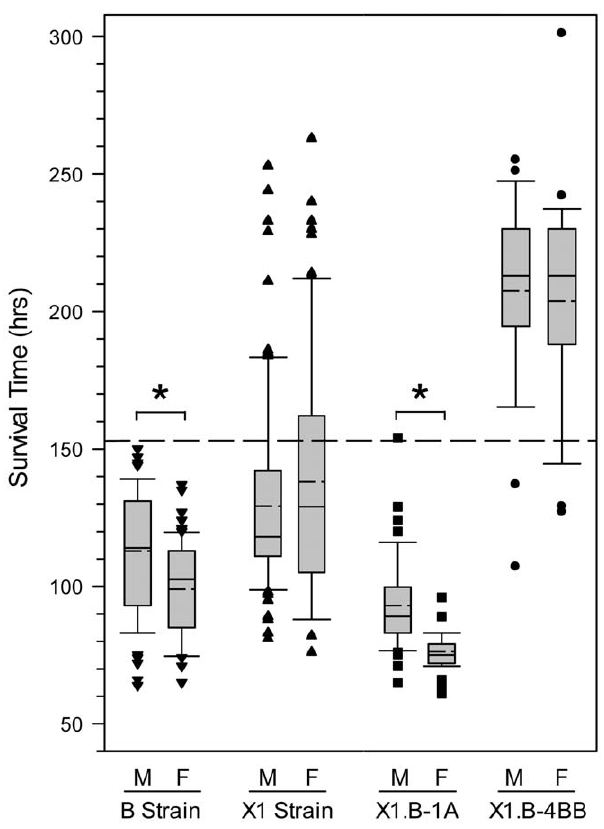
Figure 5. Box-plots comparing survival times for controls and the major Shali1 and Shali2 congenic lines. Boxes represent the 25 th to 75 th percentiles, and horizontal lines within the box represent median survival times; short dashed lines within boxes denote mean survival times. Whiskers (error bars) above and below the boxes indicate the 90 th and 10 th percentiles, respectively. The dashed line across the graph denotes the threshold survival time (153 hrs) for designation of the resistant phenotype [24]. Both sexes of all lines (B, X1.B-1A, and